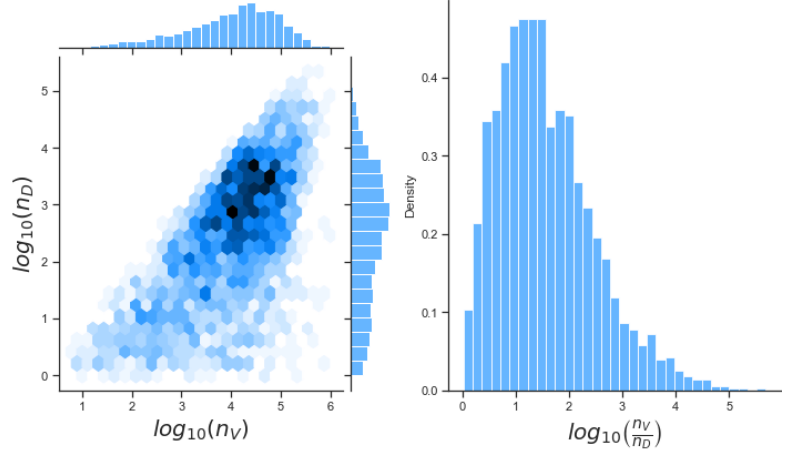
( n ) and log ( n ) showing a positive correla- D V 10 10